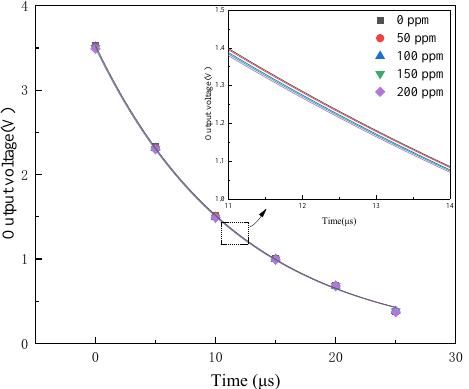
Figure 7. Fitting curve of exponential function corresponding to different CO concentrations.